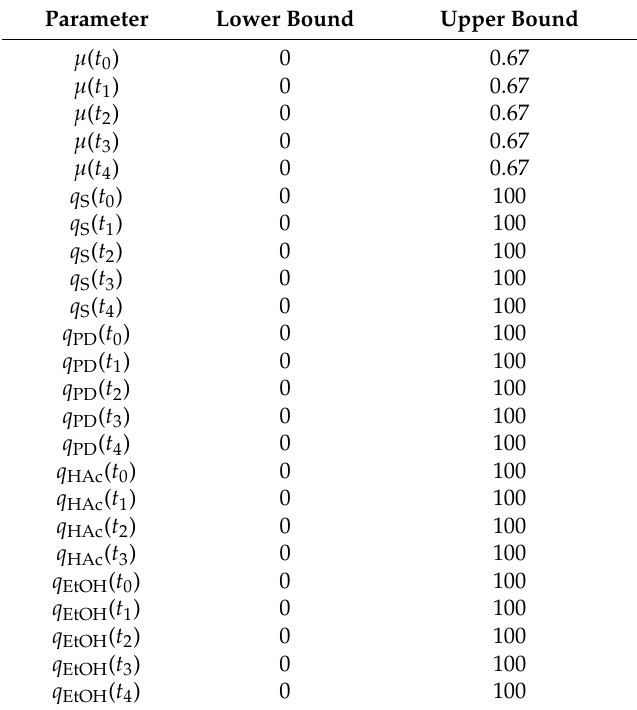
Table 1. The lower and upper bounds in the optimization problem of Equations (79)–(90). Parameter Lower